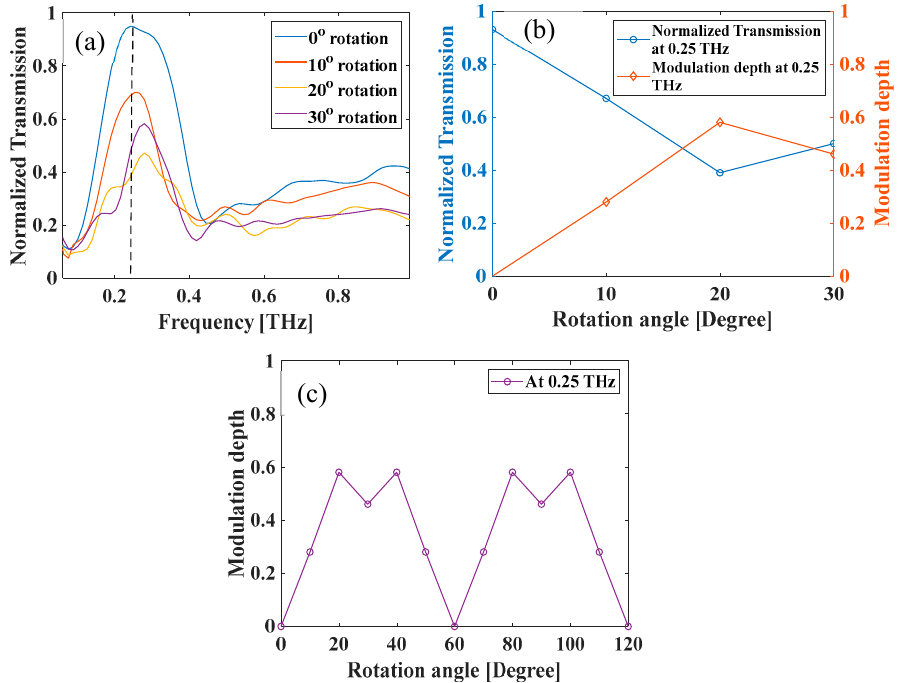
Figure 5. ( a ) Simulated normalized transmission for different rotation angles as 0°, 10°, 20°, and 30°; ( b ) normalized transmission (blue line) and modulation depth (orange line) as a function of rotation angles at operating frequency of 0.25 THz; ( c ) simulated modulation depth as a function of rotation angles from 0° to 120° at 0.25 THz.